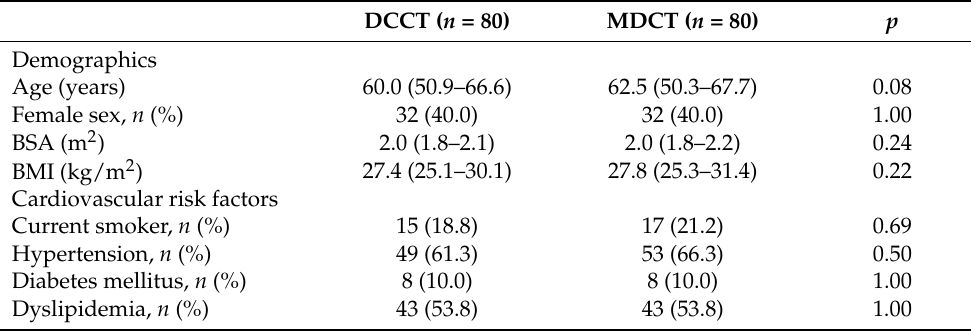
Table 1. Patient demographics and imaging